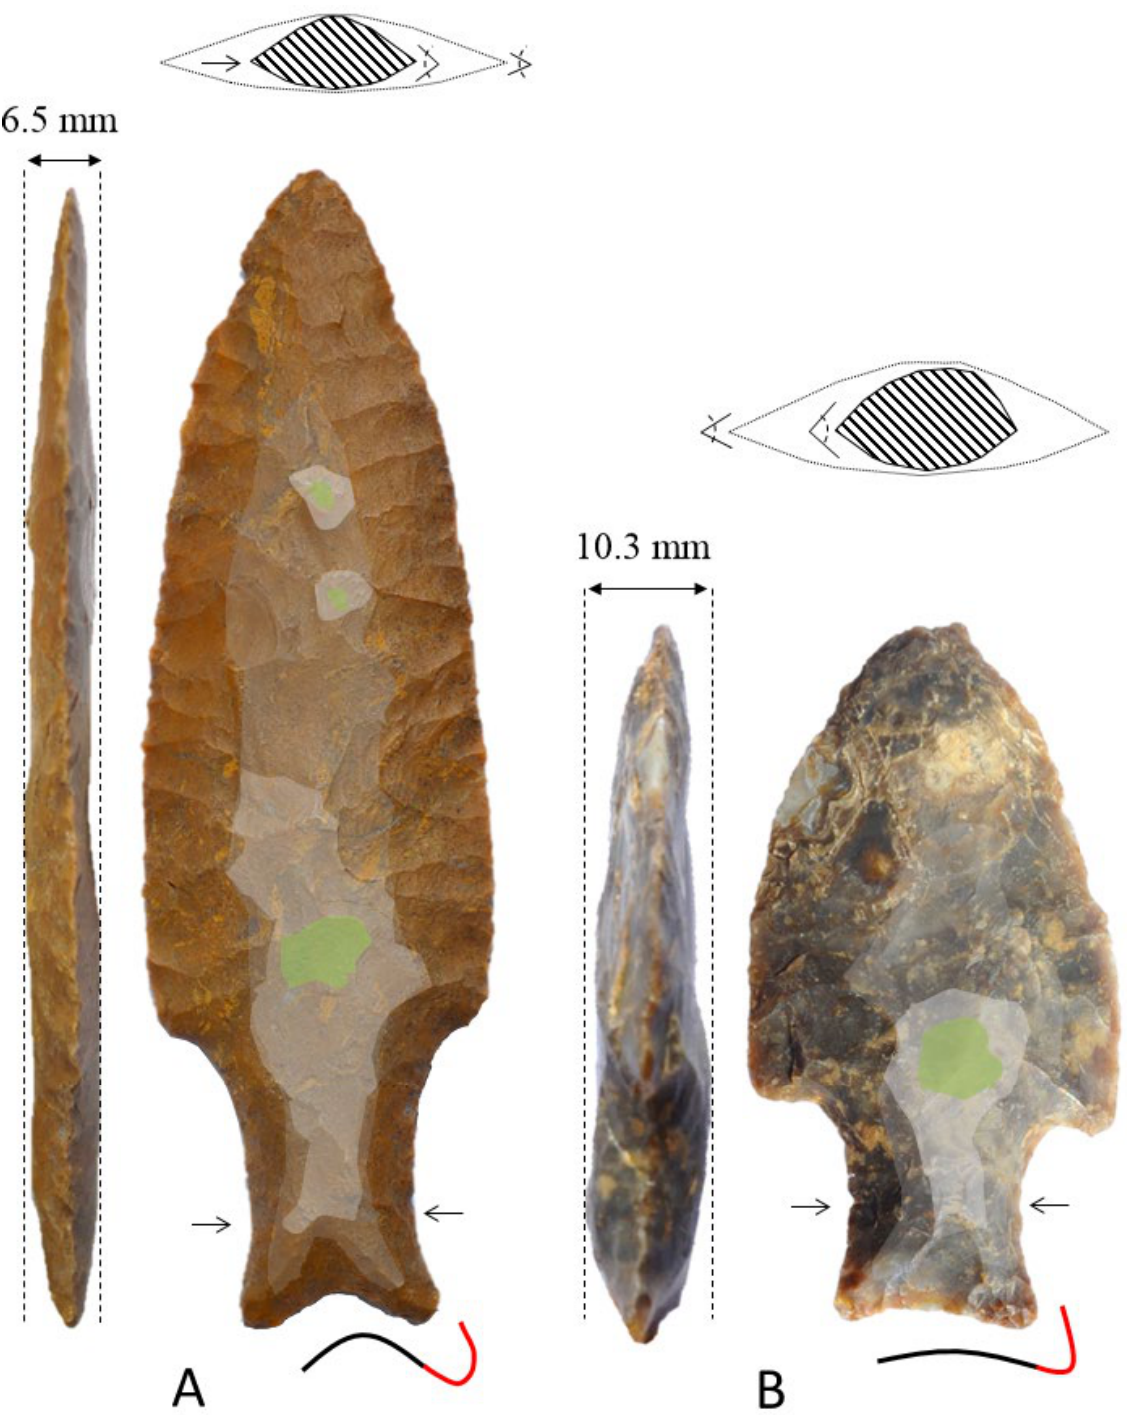
Figure 16. Topographic model (dorsal view) of a large triangular (slightly lanceolate) FP (piece A), and a reshaped triangular one (piece B). In grey, the greater thickness area; in green, the maximum thickness spots. The cross-section view compares blade and stem angle, area and perimeter. At the bottom, potential changes in the basal concavity (white lines) and ears (red lines) through the rejuvenation process. See the abrupt change in the thickness along the distal stem and blade base, and its mid sector in the rejuvenated point